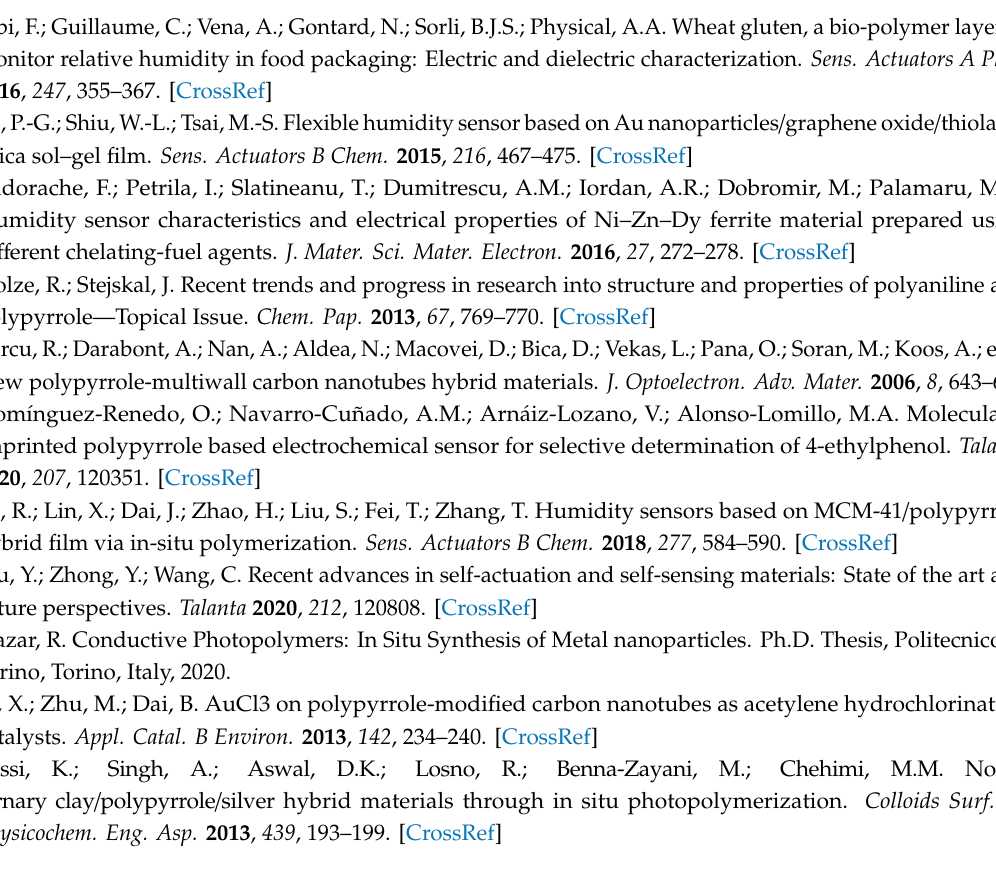
Figure S1: The hysteresis response of the HNT-DMA-PPY-AG ( 0.25 wt%, 0.5 wt%, and 1 wt%) nanocomposite based resistive humidity sensors, Figure S2: Hysteresis response of the HNT-DMA-PPY-Ag ( 0.5 wt%) nanocomposite based humidity